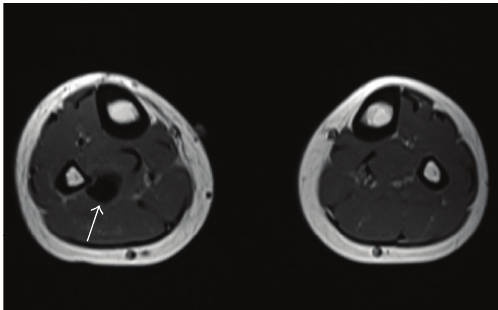
Figure 1: Axial T1 MRI of the lower extremities demonstrates a 1.6 × 1.2 × 1.5 cm signal void arrow adjacent to the right peroneal artery and vein.